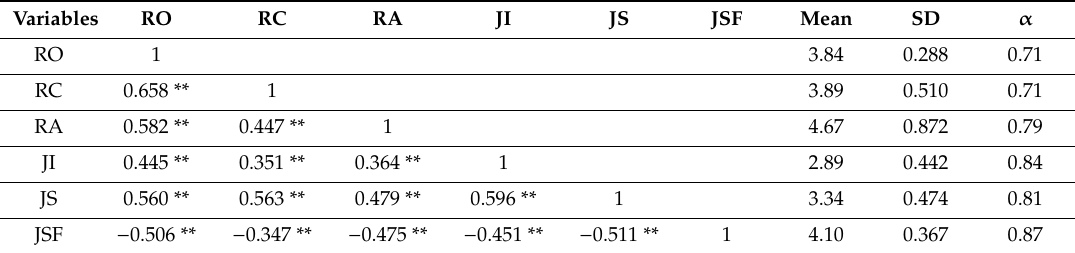
Table 1. The correlation, mean and standard deviation of the Table 1: The correlation, mean and standard deviation of the variables